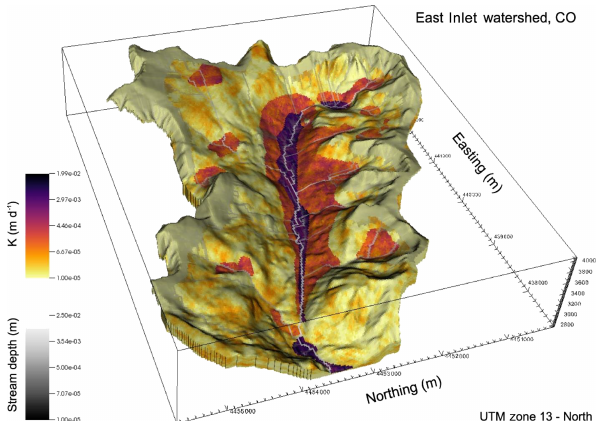
Figure 7. Map of hydraulic conductivity (K) and stream depth in the East Inlet watershed in Colorado (Engdahl and Maxwell, 2015). This domain covers 30km 2 using 3.1 million lateral grid cells. The springs emanating from within the hillslopes highlight the realism afforded by integrated modeling at small